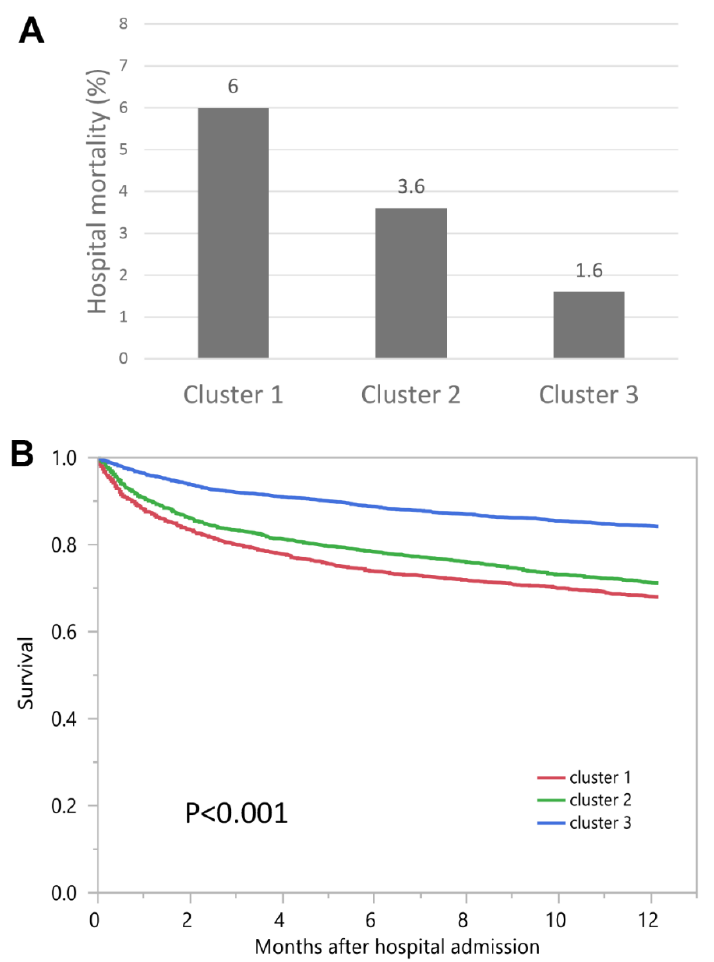
Figure 4. ( A ) Hospital mortality among different clusters of admission hyponatremia; ( B ) One-year mortality among different clusters of admission hyponatremia. Table 2. Mortality outcomes according to clusters.